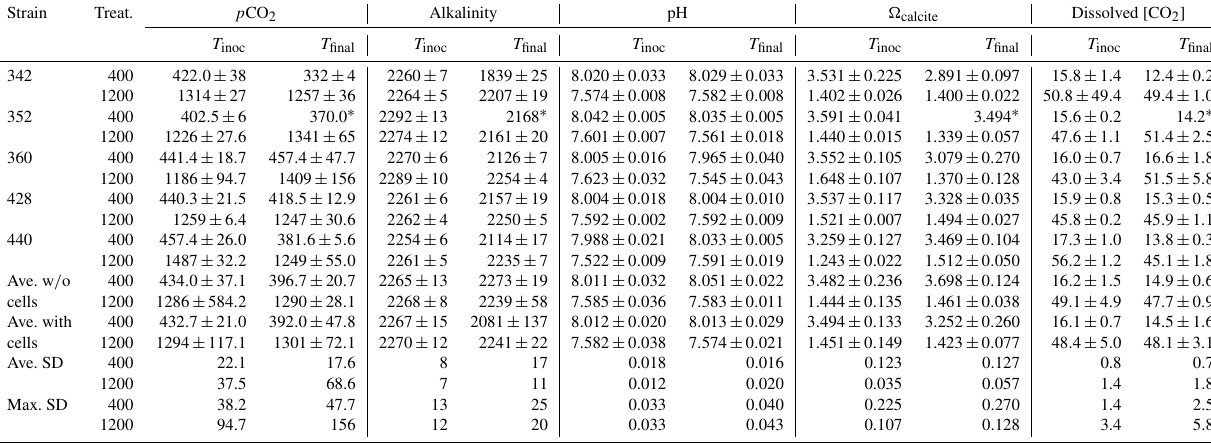
Table 2. Carbonate system parameters during experiment. Means ± SDs of experimental replicates at the time of inoculation ( T inoc ) and harvesting ( T final ) are given. The pH at the experimental temperature is calculated from measured pH at 25 ◦ C. Treatment is specified by CO 2 partial pressure (µatm) of air : CO 2 mix. p CO 2 units are µatm; alkalinity and [CO 2 ] units are µmolkg − 1 . The average ± SDs across strains for cell-free control bottles and mean experimental bottle values are also provided. The last two rows give the average and maximum SDs among replicates among all strains.